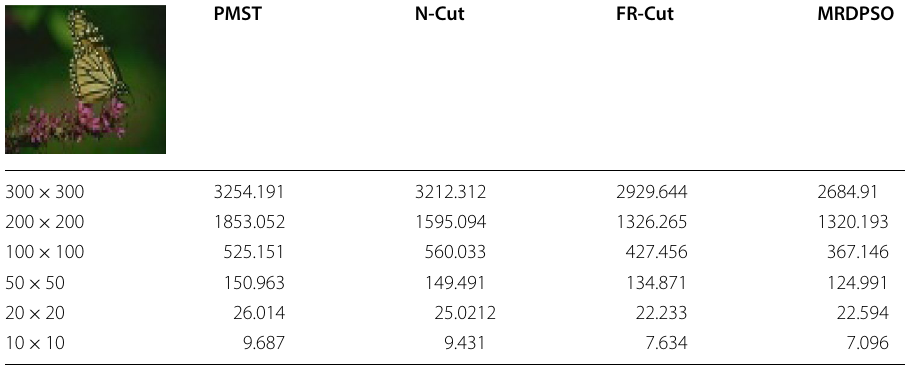
Table 3 Algorithm execution time for distinct sizes of an image PMST N-Cut